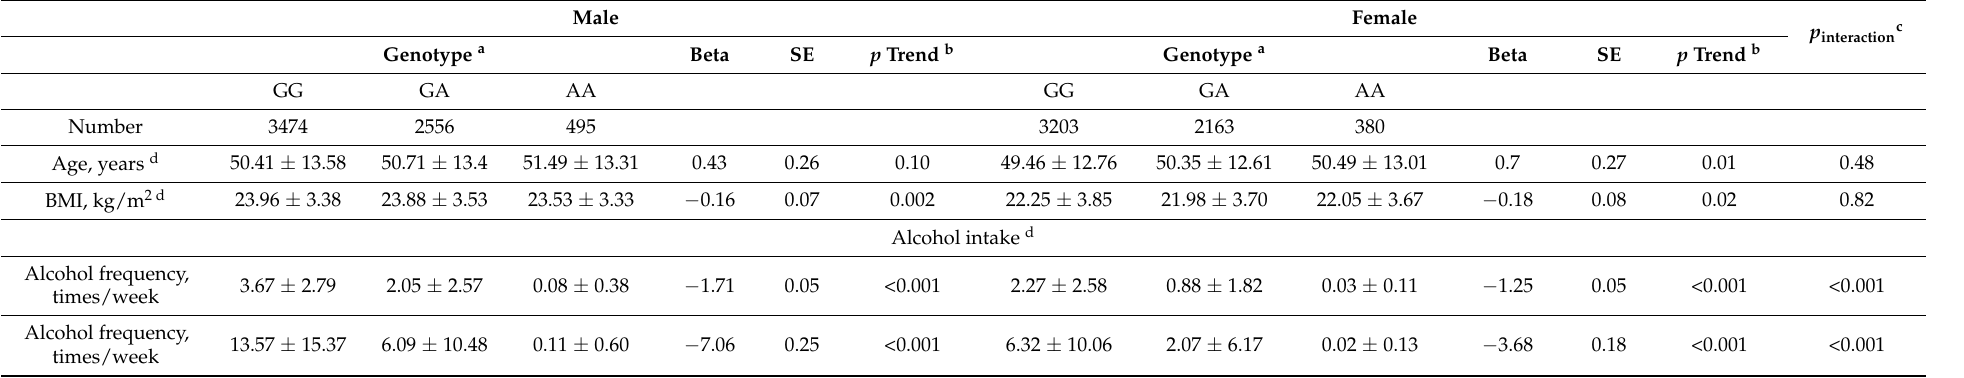
Table 1. Characteristics of